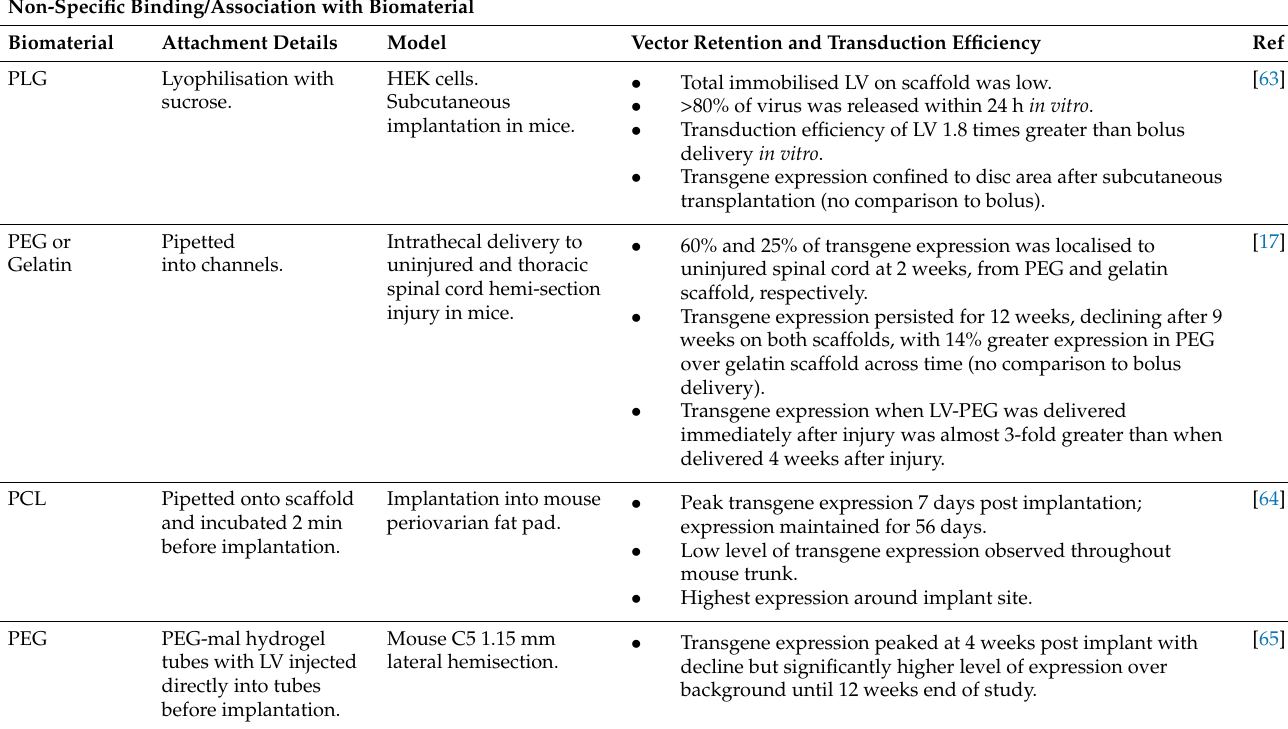
Table 1. Studies using non-specific binding/association for LV delivery on biomaterials. PLG; poly (lactide-co-glycolide), CL; Poly ( ε -caprolactone), PEG; Polyethylene (glycol). Non-Specific Binding/Association with Biomaterial Biomaterial Attachment Details Vector Retention and Transduction